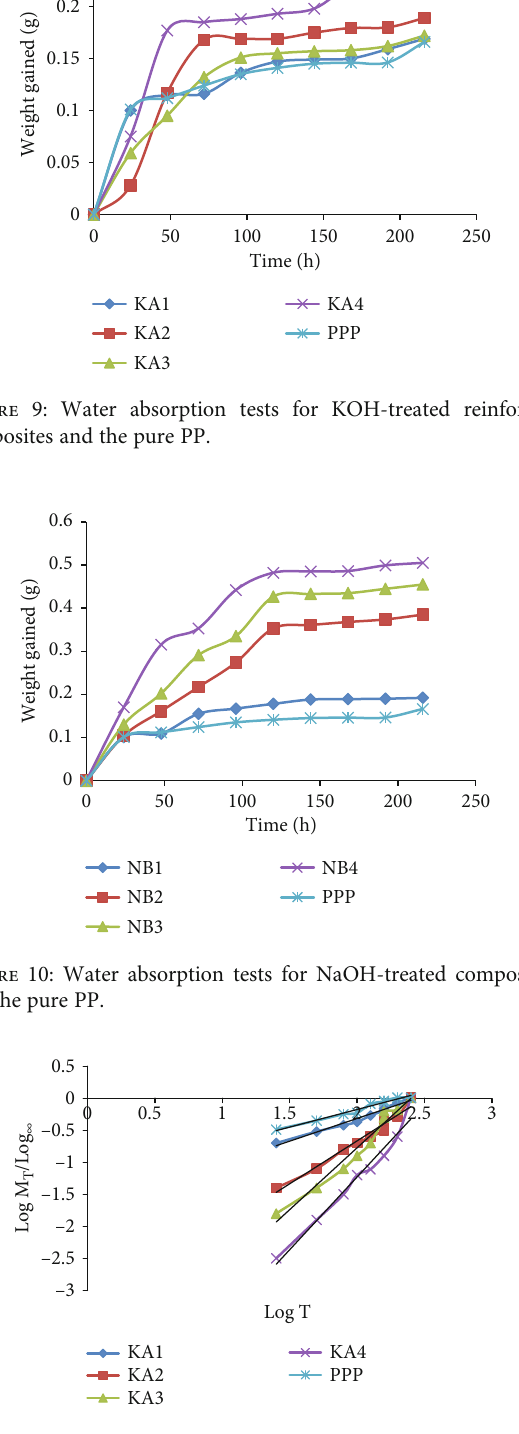
Figure 11: Di ff usion mechanism curve for KOH-treated composites and the pure